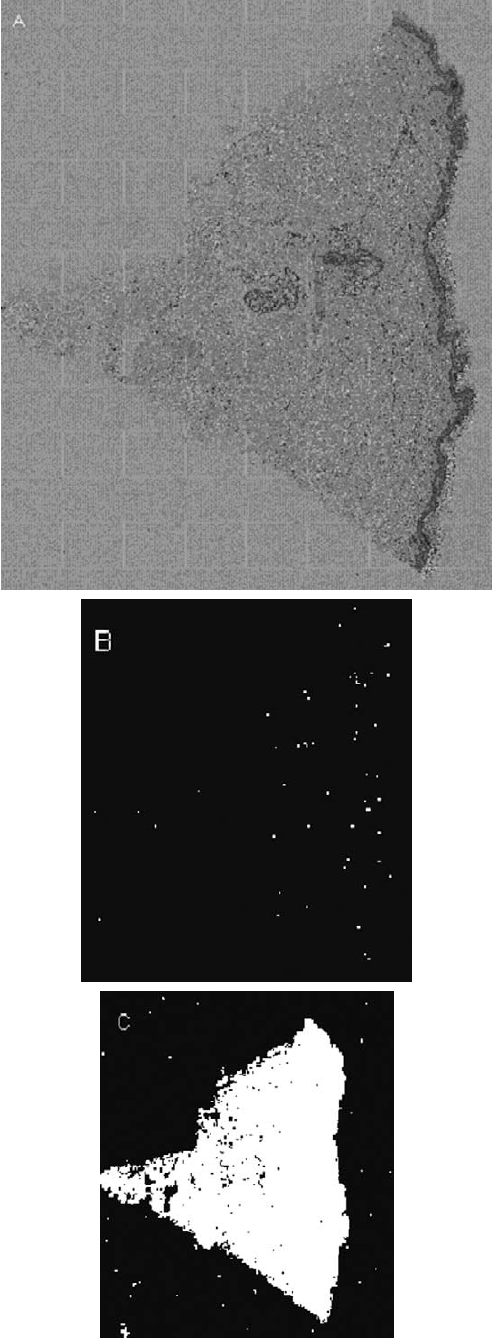
Fig. 5. De-magnified image of LCA immunostaing of an adjacent section of the same tissue as displayed in Fig. 4. Overview (A); Im- munopositive architecture (B); Immunonegative architecture